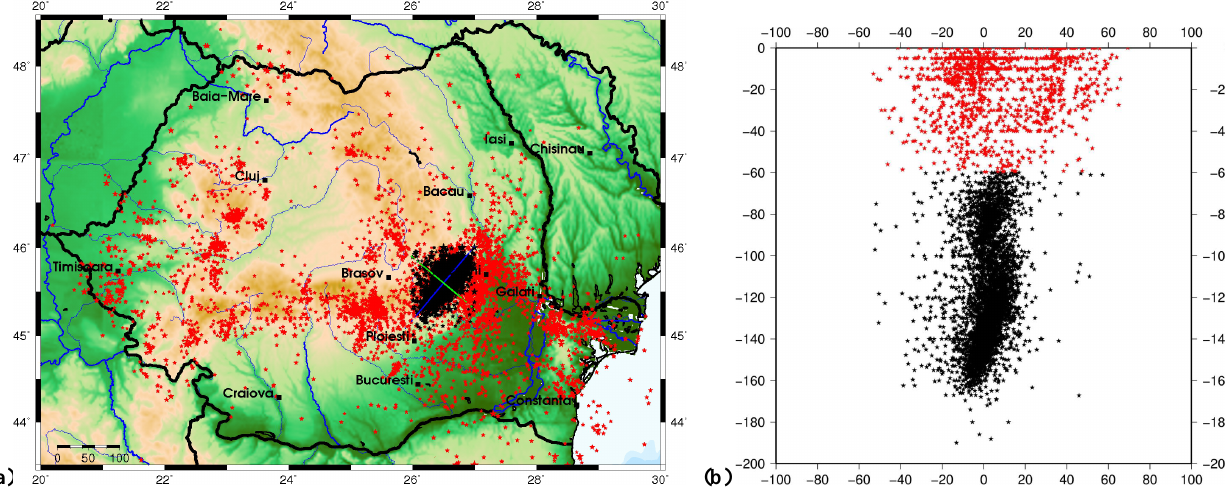
Fig. 1. (a) Map showing seismicity of the SE-Carpathians and surrounding regions during the last century (the hypocenter catalog, ROMPLUS, provided by the National Institute for Earth Physics – NIEP, was adopted for the study). Red colour shows shallow seis- micity. Black colour shows intermediate-depth seismicity. Note that the main source of earthquake hazard, the intermediate-depth events, is clustered in a small elliptical-geometry area to the North of Bucharest (b) NW-SE cross section of seismicity (azimuth N130 ◦ E). Table 1. List of earthquakes analyzed in this study. Earthquake parameters after Oncescu and Bonjer (1997). 1σ is static stress drop (bar): 1977 event after Tavera (1991), 1986 event after Oncescu (1987) and 1990 event after Trifu et al. (1992). No Date Latitude Longitude Depth Mw 1σ Strike Dip Rake ( ◦ N) ( ◦ E) (km) ( ◦